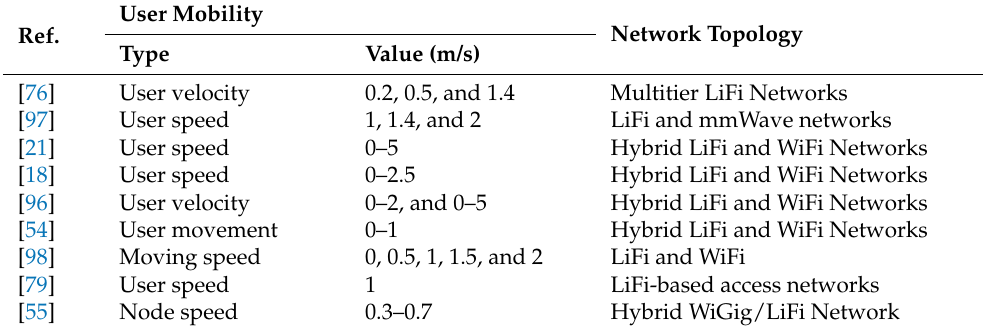
Table 2. User speed/velocity values used in previous studies in LiFi networks.